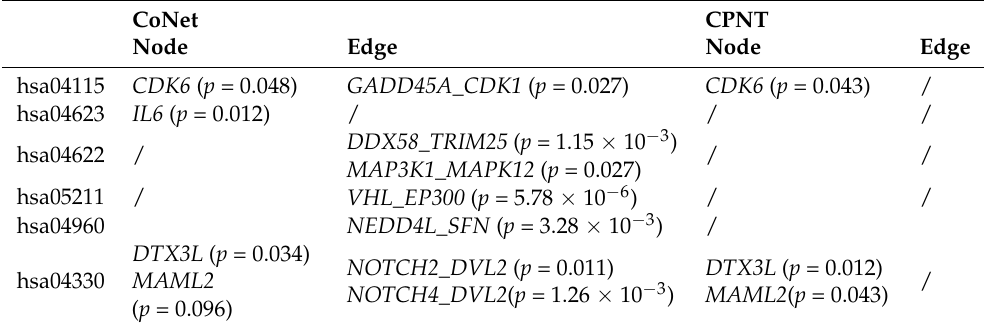
Table 4. Significantly affecting nodes and edge for two methods with p -values being corrected by FDR. CoNet CPNT Node Edge Node